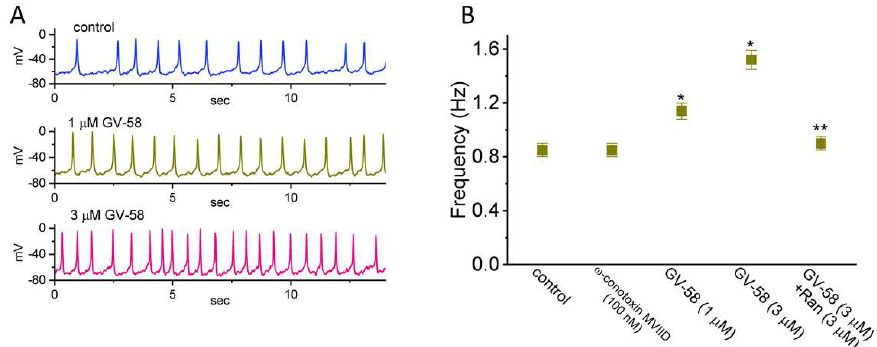
Figure 11. Effects of GV − 58 on spontaneous action potentials (APs) recorded from GH 3 cells. Cells were bathed in normal Tyrode’s solution, and the recording pipettes were filled with K + − containing solution. When whole − cell configuration was established, we switched to the whole − cell current clamp recordings to measure changes in membrane potential, as current was set at zero. ( A ) Repre- sentative potential traces achieved in the absence (upper) and presence of 1 μM GV − 58 (middle) or 3 μM GV − 58 (lower). ( B ) Summary graph demonstrating effect of ω − conotoxin MVIID, GV − 58, and GV − 58 plus ranolazine (Ran) on the firing frequency of APs in GH 3 cells (mean ± SEM; n = 8). * Significantly different from control ( p < 0.05) and ** significantly different from GV − 58 (3 μM) alone group ( p < 0.05) . Statistical analyses were made in one − way ANOVA among different groups ( p < 0.05).